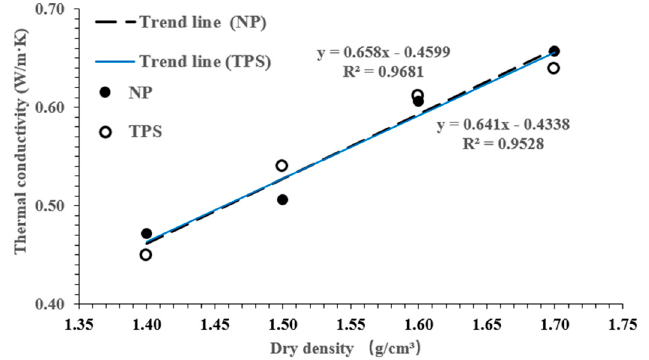
Figure 7. Thermal conductivity of compacted bentonite at varying dry densities.